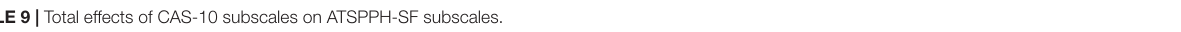
TABLE 9 | Total effects of CAS-10 subscales on ATSPPH-SF subscales. Predictor Outcome Estimate Std. Error Coronavirus concern Exaggerated